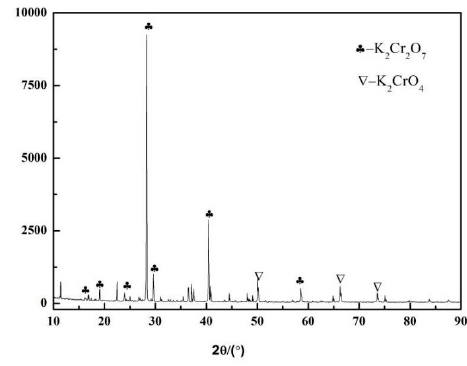
Figure 11. XRD pattern of the final product.